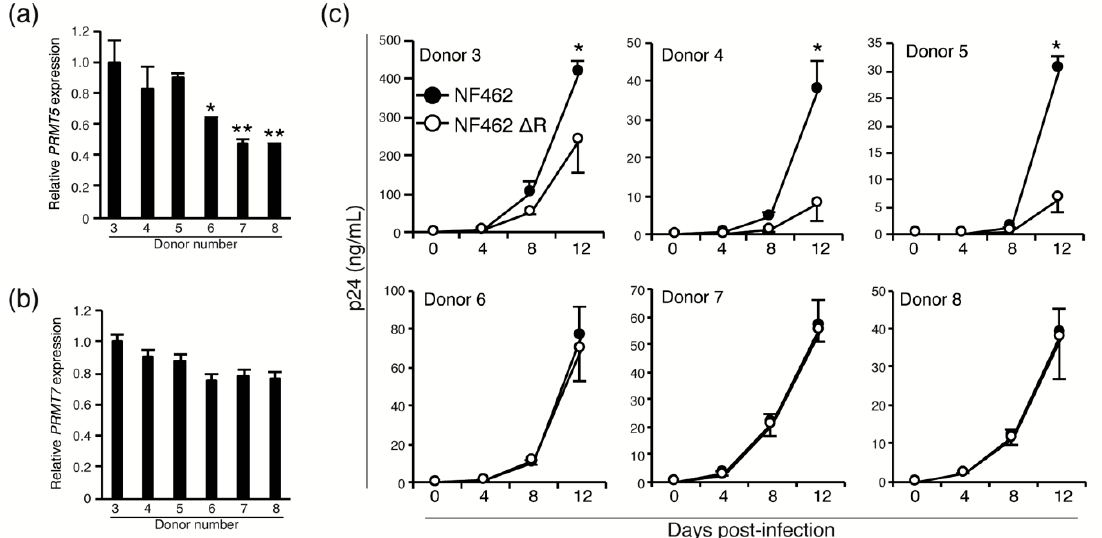
Figure 5. Differential expression of PRMT 5 in MDMs affected virus production. Expression of PRMT5 ( a ) and PRMT7 ( b ) mRNA in MDMs from six healthy donors. ( c ) MDMs from each donor were infected with the NF462 WT or NF462 Δ R strain, and virus production was measured using p24 ELISA at 0, 4, 8, and 12 days post-infection. Values shown are mean values, with error bars indicating standard deviations. Experiments were independently conducted in triplicate. Statistically significant differences are indicated by single and double asterisks (* p < 0.05 and ** p < 0.01, respectively).